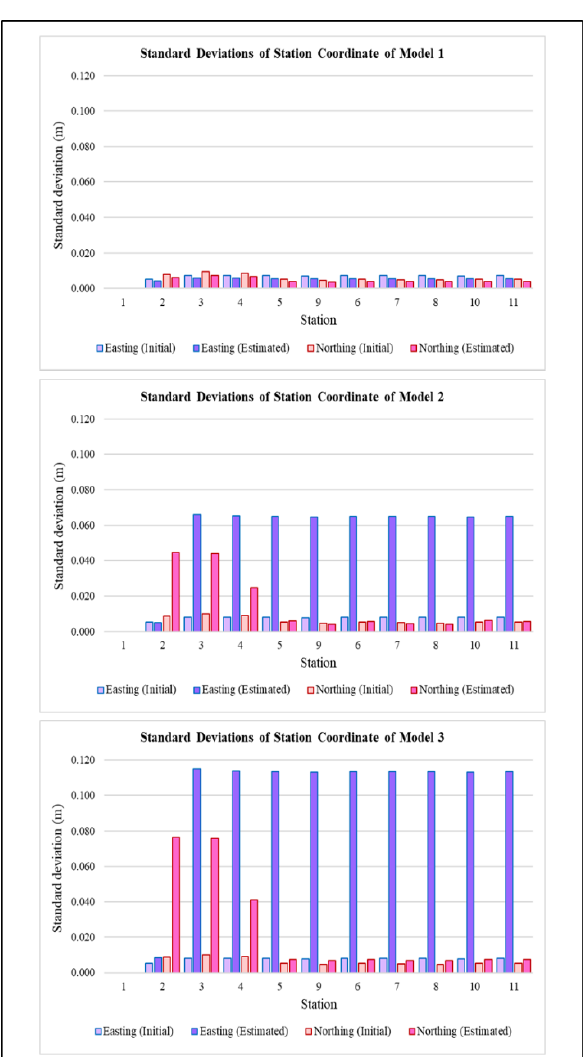
Figure 6. Estimated standard deviation of each station for Dataset 1 (EDM, theodolite and total station) Based on the results showed, Model 3 which was the combined model indicated the smallest absolute values of W- test statistic. This means that Model 3 has less error contribution in its adjustment computation. Even though the